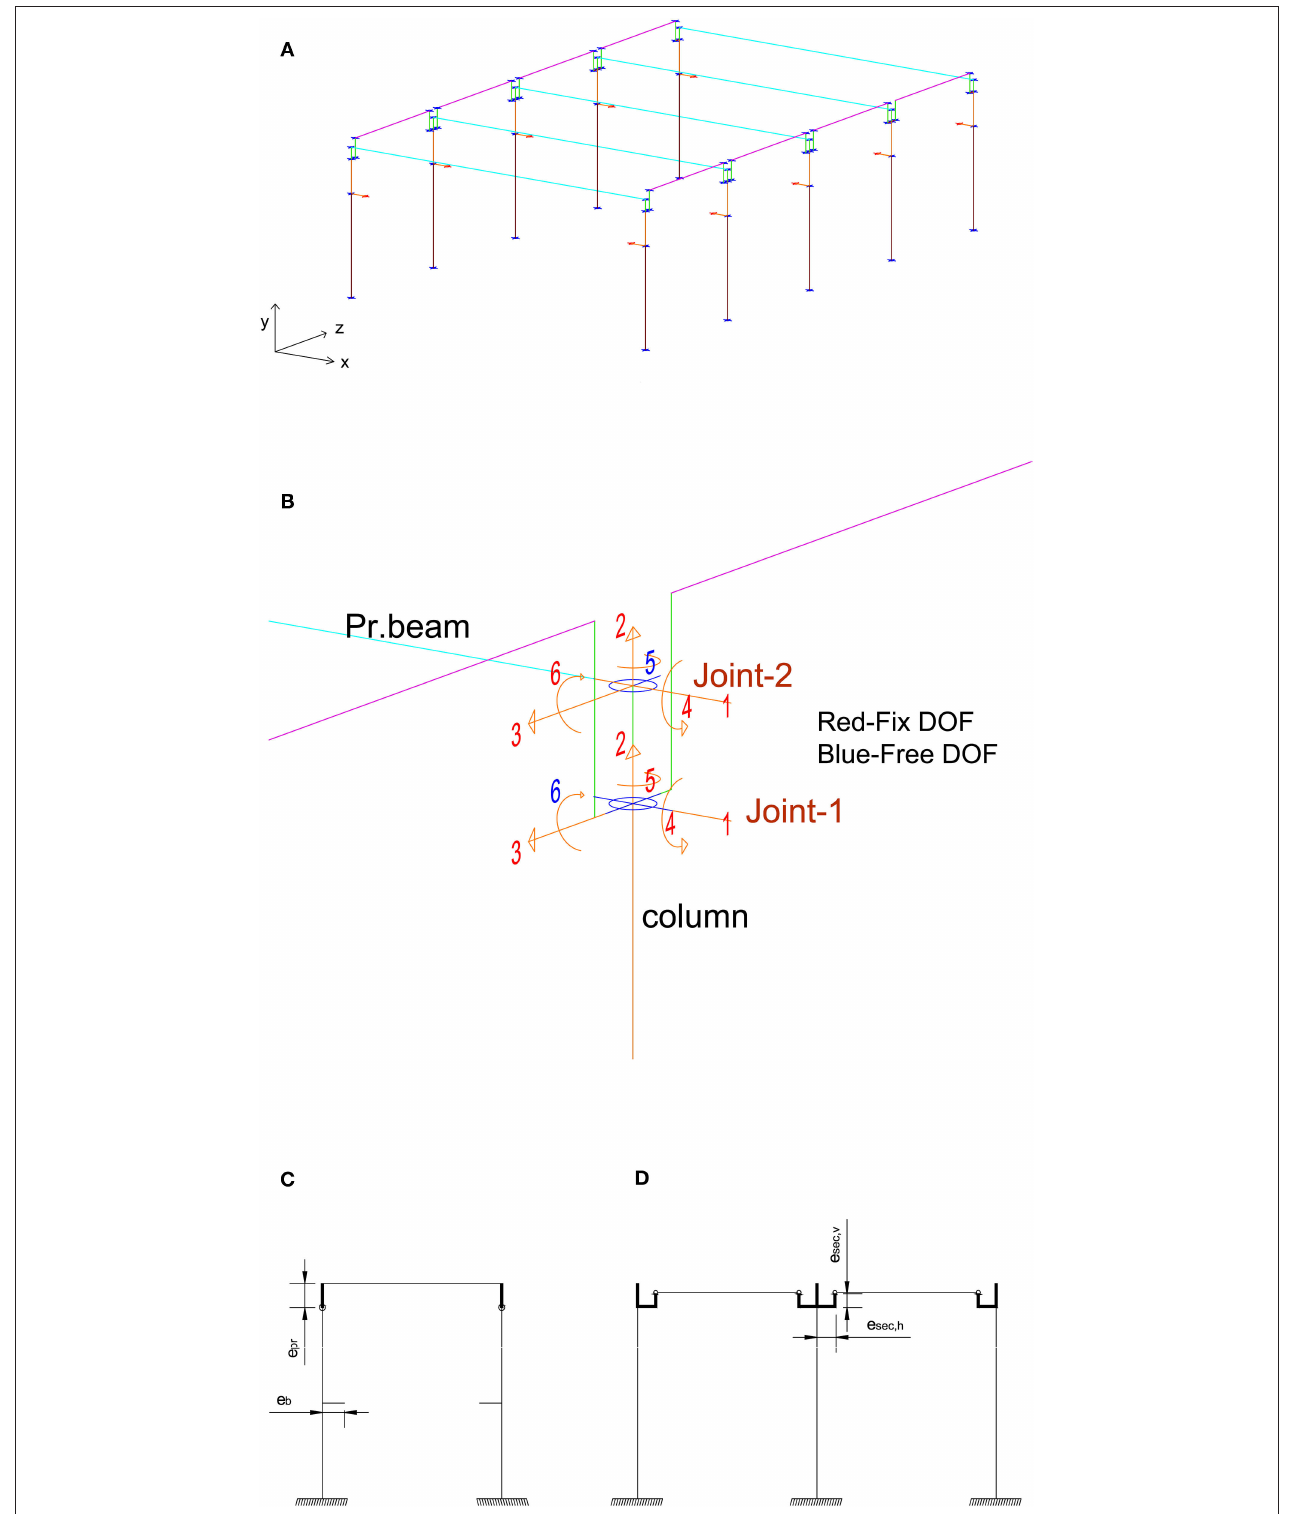
FIGURE 2 | (A) 3D view of the numerical model developed in OpenSees (B–D) model joint details.